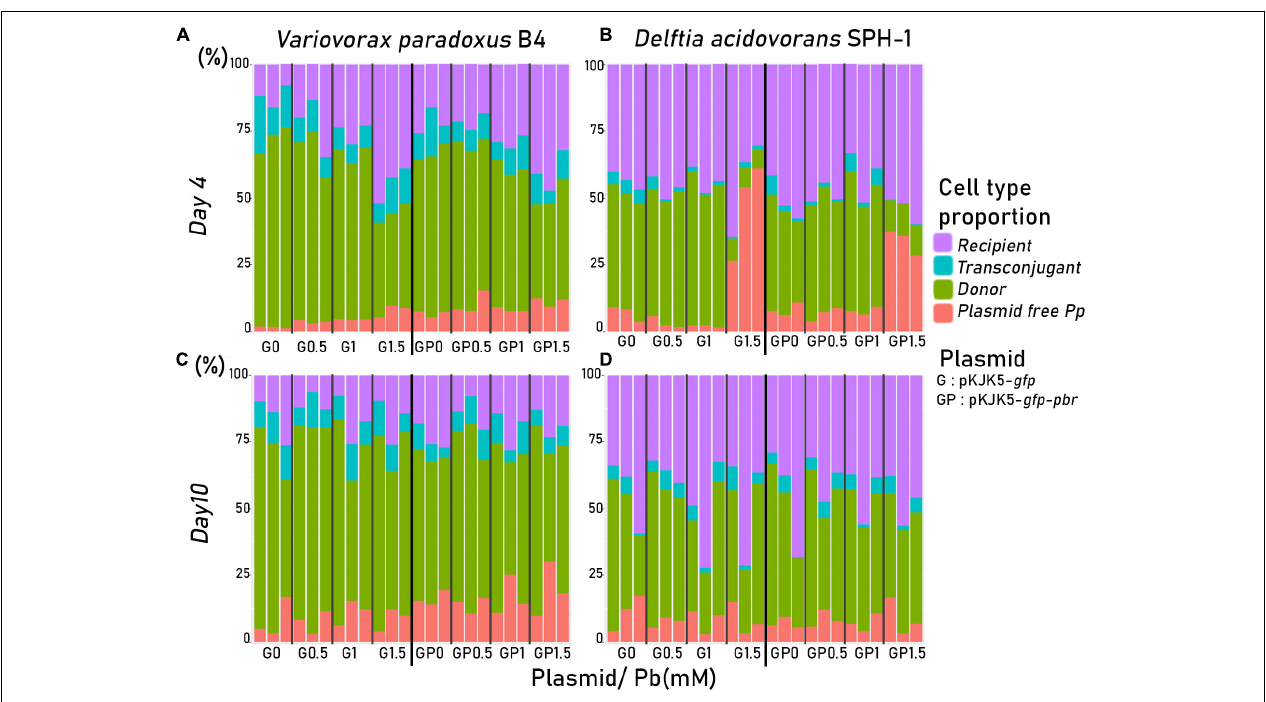
FIGURE 3 | Cell proportions measured among 30,000 cells after 4 days (A,B) or 10 days (C,D) of co-culture using a BD Science FACS Fortessa flow cytometer. Plasmid-carrying cells were detected by green fluorescence associated with GFPmut3. Pseudomonas putida KT2440 was identified by flow-FISH using an Alexa Fluor 647 fluorescent specific probe. The associated spread index is displayed in Figure 4